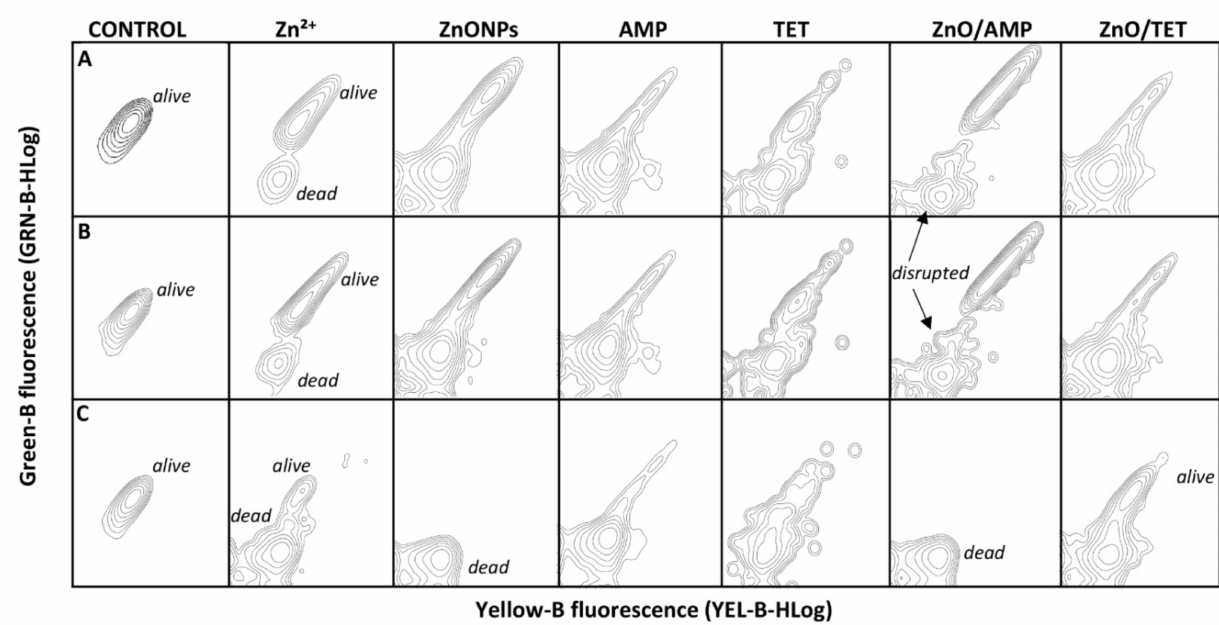
Figure 7. Fluorescence spectra of E. coli ( A ), S. epidermidis ( B ) and K. pneumoniae ( C ) bacteria cells treated with ampicillin (AMP), tetracycline (TET), zinc ions (Zn 2+ ) and zinc oxide nanoparticles (ZnONPs), before and after immobilization with AMP (ZnONPs/AMP) and TET (ZnONPs/TET), as well as non-treated bacteria